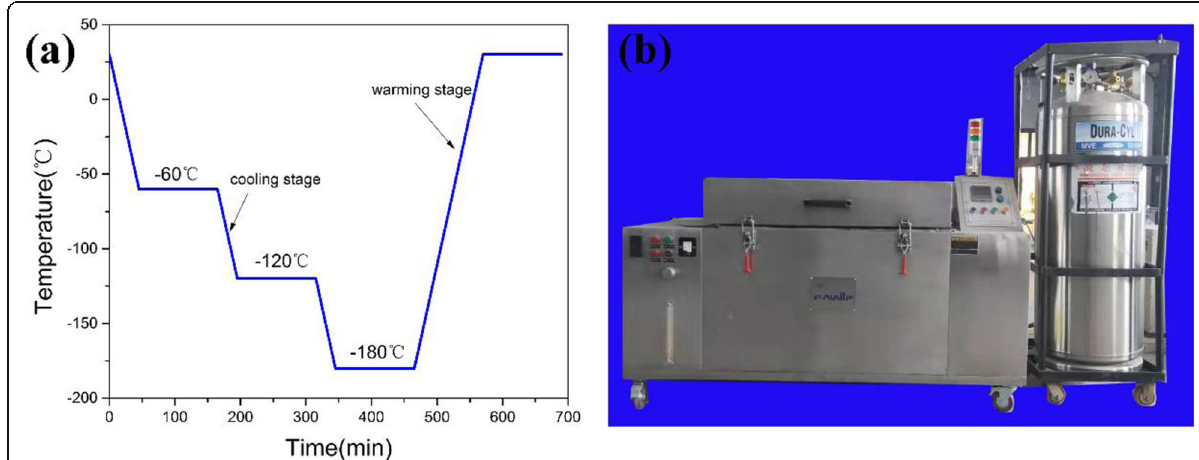
Fig. 2 a Process curve of the cryogenic treatment. b Program-controlled cryogenic